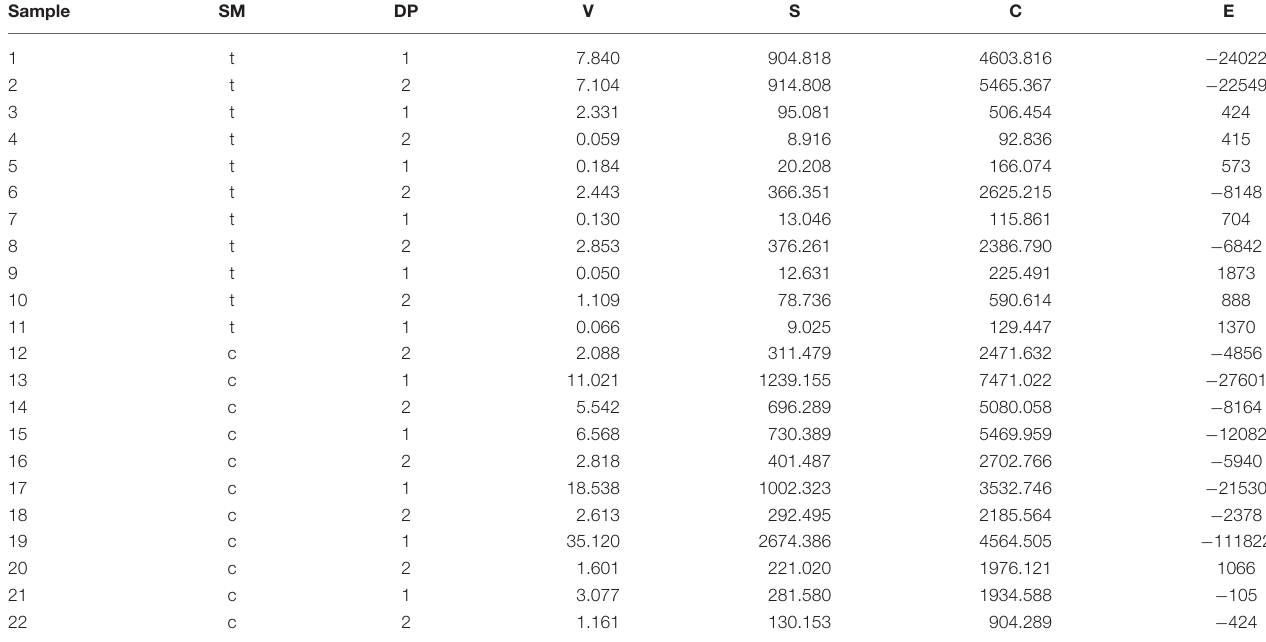
TABLE 1 | Minkowski functionals for the different images.